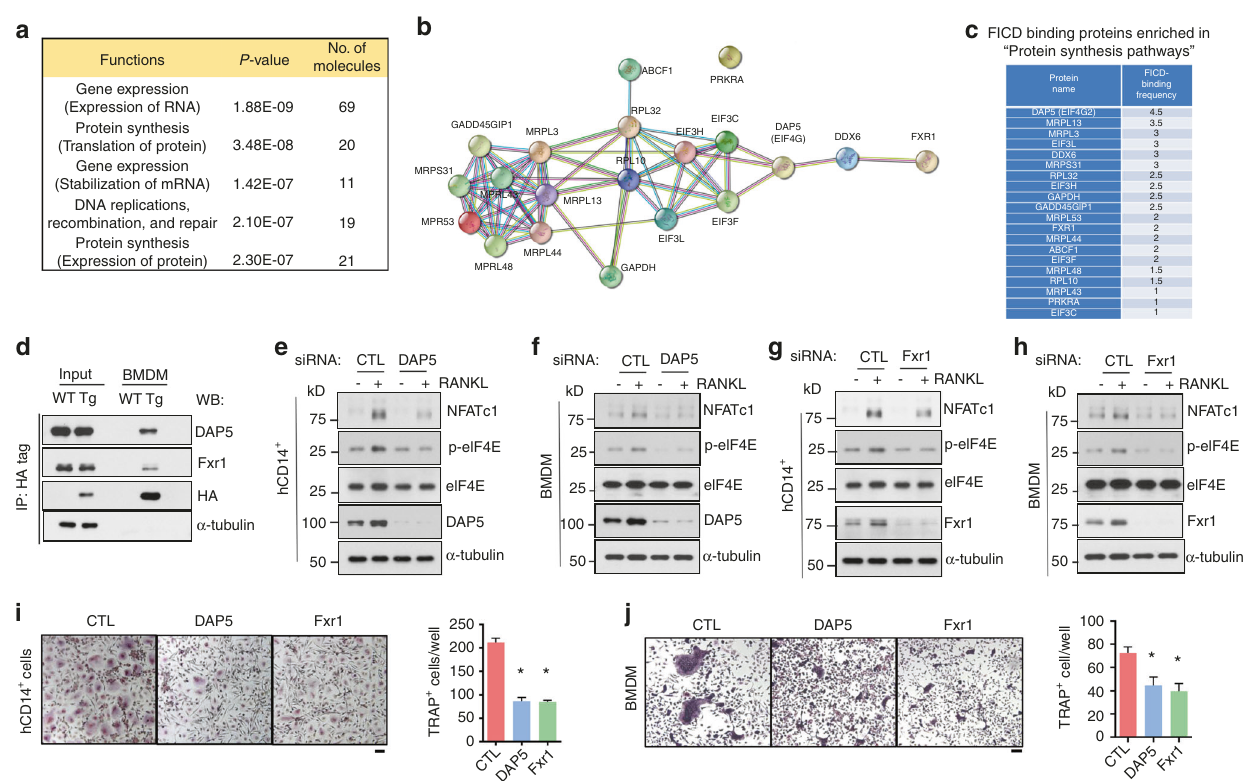
Fig. 7 The FICD enhances the activation of MNK1/2/eIF4E via DAP5/Fxr1. a Ingenuity pathway analysis of 145 FICD-interacting proteins. Pooled data from two biological replicates were analyzed. b Interaction map showing 20 FICD-interacting proteins in “ Protein synthesis pathways ” using STRING functional protein association analysis. c Frequencies of the proteins shown in ( b ). d The interaction of the FICD with DAP5 or Fxr1 was determined by immunoblot analysis with anti-DAP5, Fxr1, HA, or α -tubulin antibodies. Whole cell lysates of BMDMs from WT and FICDtg M mice were used for immunoprecipitation with anti-HA-tagged antibodies. Knockdown (KD) of DAP 5 ( e , f , i , j ) or Fxr1 ( g , h , i , j ) in both human CD14 + cells ( e , g , i ) and BMDMs ( f , h , j ). e – h The protein expression of NFATc1, p-eIF4E, eIF4E, DAP5, Fxr1, and α -tubulin was determined by immunoblot analysis. Osteoclastogenesis assay. KD of DAP5 or Fxr1 in hCD14 + cells ( i ) or in BMDMs ( j ) that were cultured with M-CSF and RANKL for 3 days. The left panel shows representative images of TRAP-stained cells. The right panel shows the percentages of TRAP-positive multinuclear cells (MNCs: more than three nuclei) per control from three independent experiments. CTL Control siRNAs. All data are shown as the mean ± SEM. * P < 0.05 by one-way ANOVA with a post hoc Tukey test ( i , j ). The data represent 2 biological replicates for mass spectrometry ( a – c ) and three independent experiments ( d – i Taken together, our fi ndings suggest that the FICD promotes osteoclast differentiation by permitting the sustained activation of MNK1/2 and eIF4E phosphorylation, and in turn, NFATc1 expres- sion is increased and enhances FICDtg M osteoclast formation (Supplementary Fig. 11).